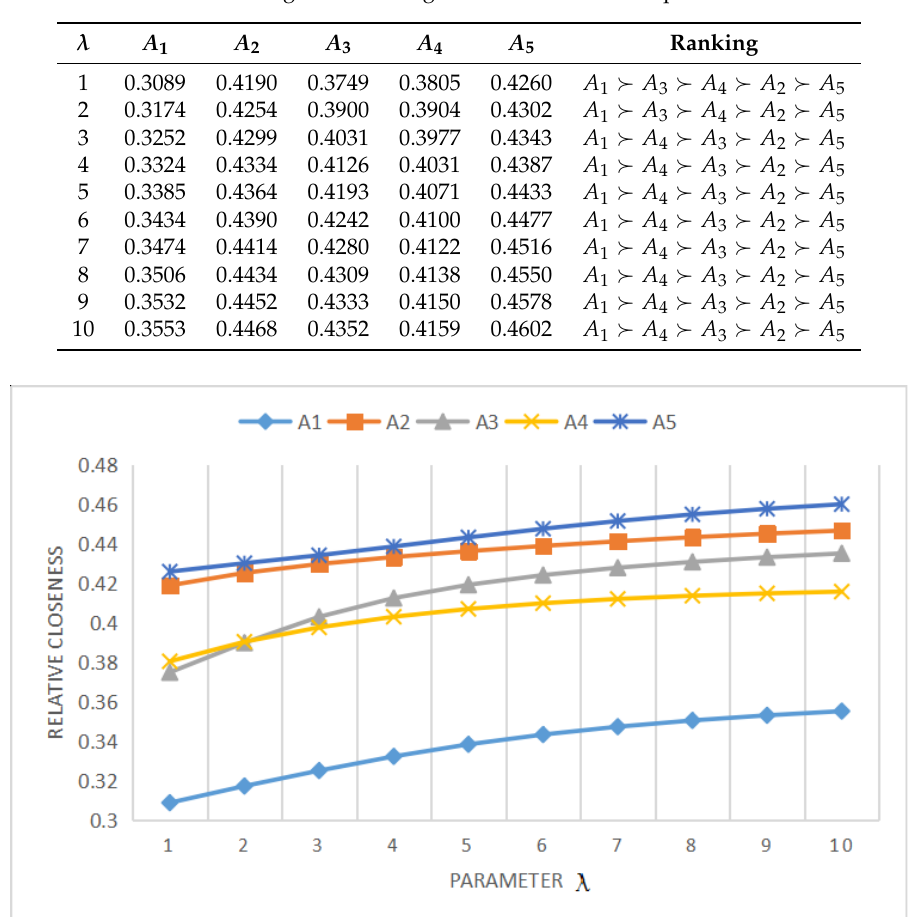
Table 7. Ranking results taking different values of the parameter λ .